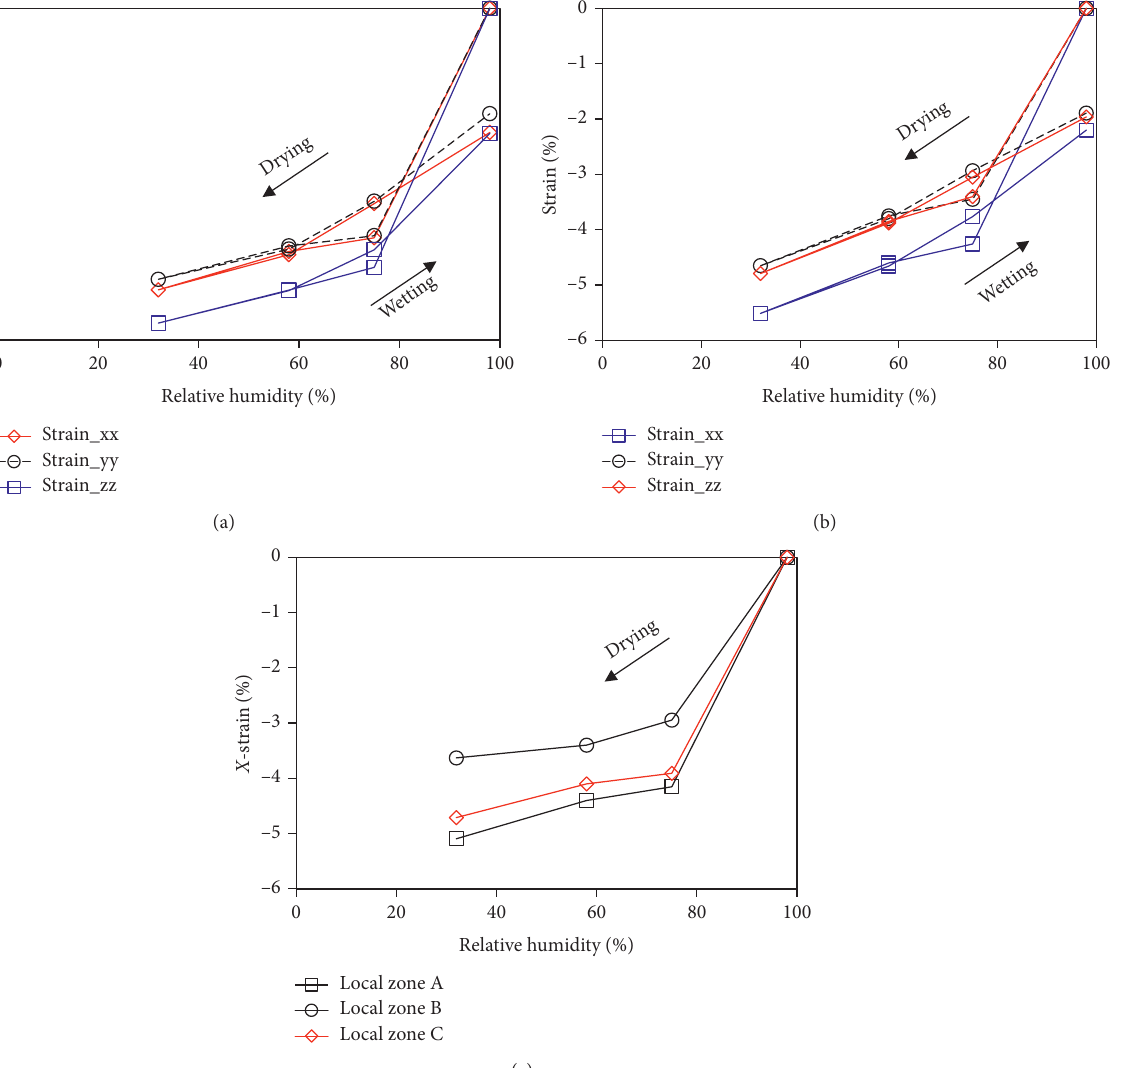
Figure 4: Strain versus relative humidity curves during drying and wetting: (a) sample No.1; (b) sample No. 2; (c) three zones of the sample No. 1 (“ − ” means